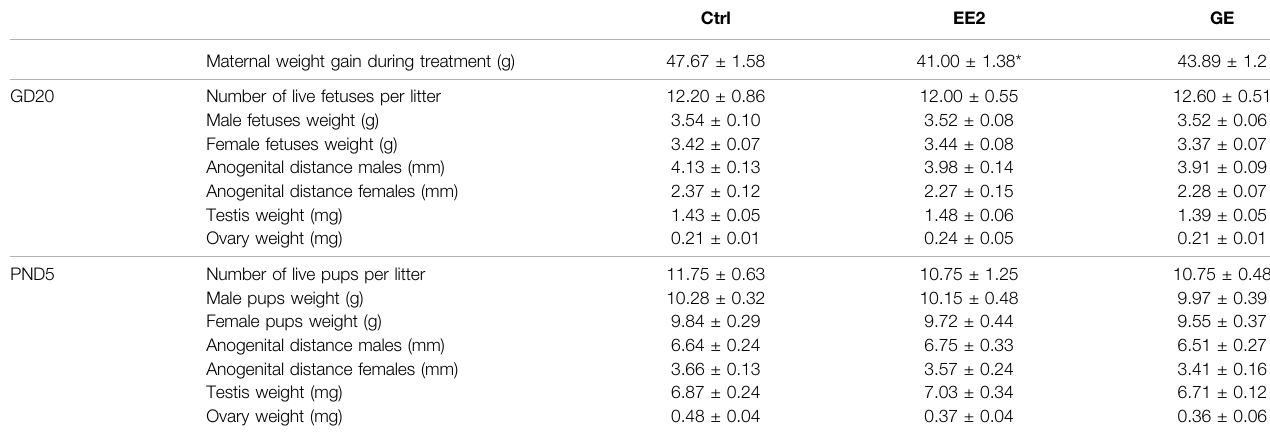
TABLE 1| Effectof inutero exposuretoethynil estradiol (EE2)orgensitein(GE) onperinataldevelopment.Females wereexposed bygavagefrom gestational day (GD)13to 19. Progeny was sacri fi ced on GD20 (n = 5 litters) or post-natal day 5 (PND5, n = 4 litters). Male and females were counted and weighted. Ano-genital distance was measured from anus to tip of genital tubercle and gonads were sampled and weighted. * p < 0.05 compared to control using a non-paired t -test.